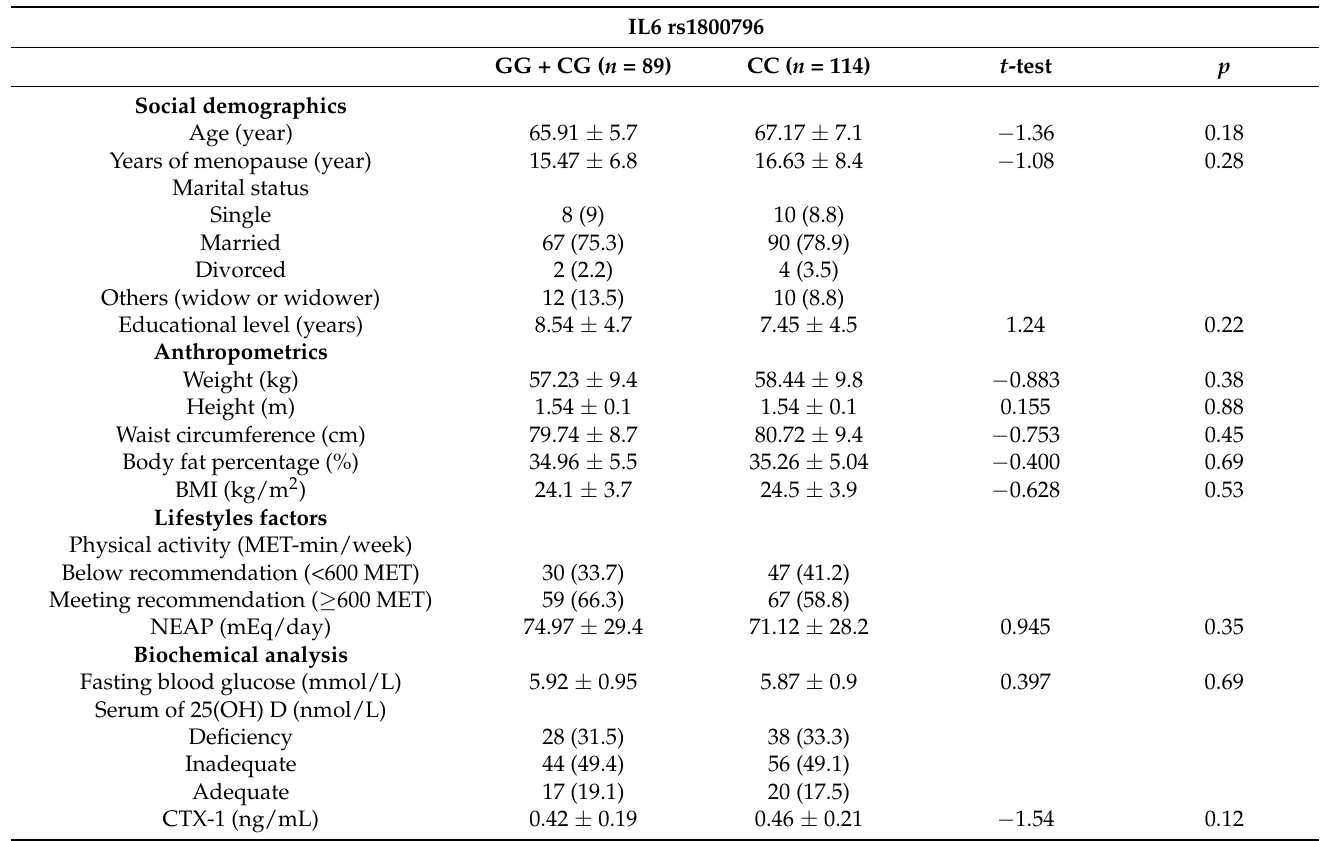
Table 3. Demographic, anthropometrics, lifestyle factors, and biochemical analysis according to IL6 gene -572G/C.